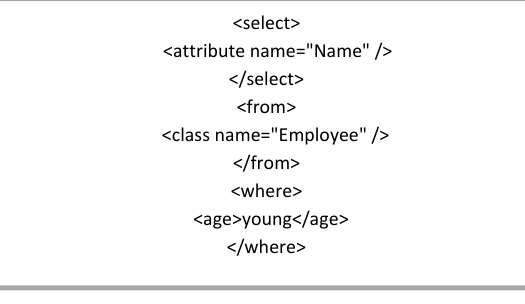
Fig. 10. Executing first query